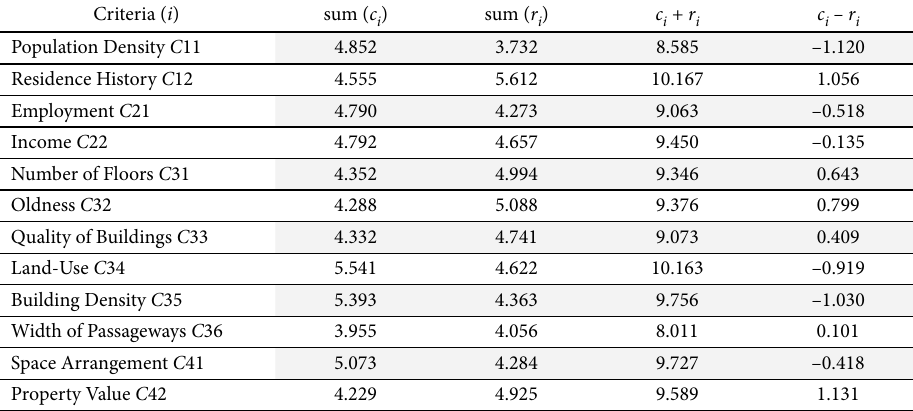
Table 6. Sum of influences given and received for